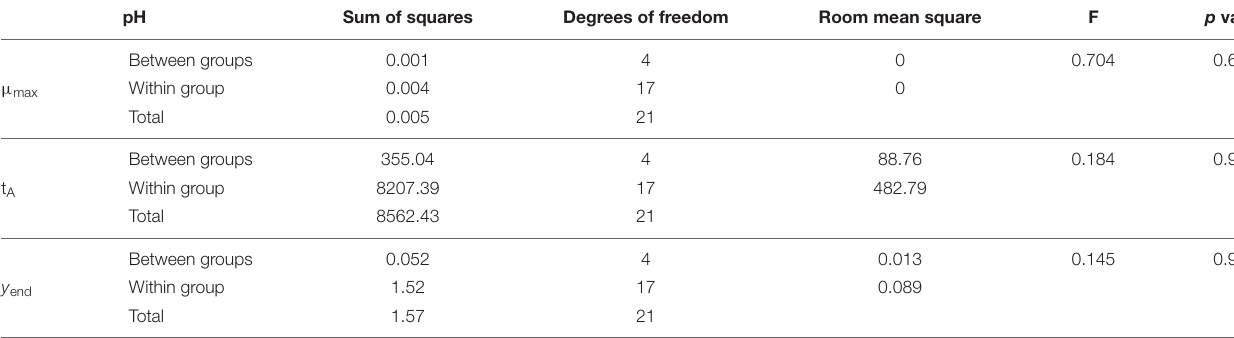
TABLE 2 | One-way ANOVA for pH in the kinetic parameters of Vibrio spp. Sum of squares Degrees of freedom